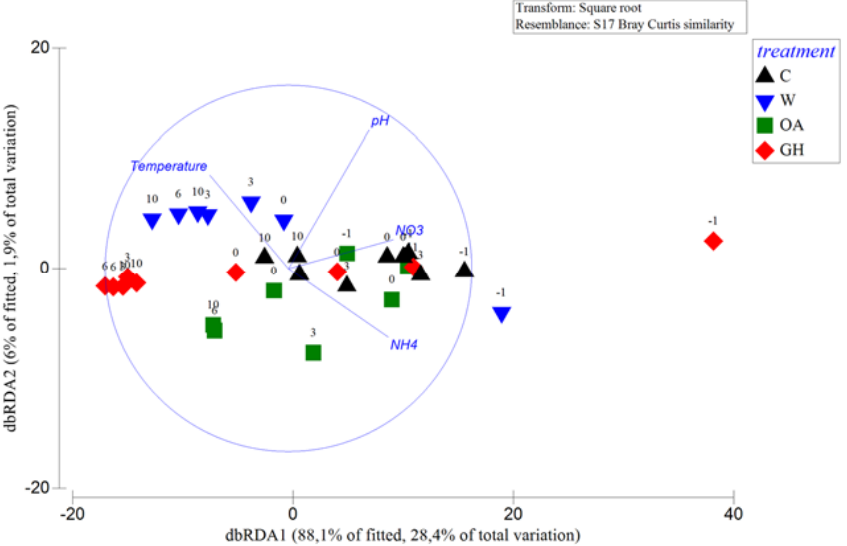
Figure 3. Distance-based redundancy analysis (dbRDA) plot of the distance-based linear model of the pH and temperature measurements and the concentrations of nitrate (NO 3 − ) and ammonium (NH 4+ ) fitted to the bacterial community composition (genus level). The length and direction of the vectors indicate their relative strength and direction of relationship in the ordination plot, respectively. Community similarity was calculated via the Bray–Curtis index after a square–root transformation of the bacterial genera read counts. The samples are presented based on the mesocosm treatment (symbols) and experimental day (numbers above symbols). For the treatment abbreviations, please refer to Figure 1.